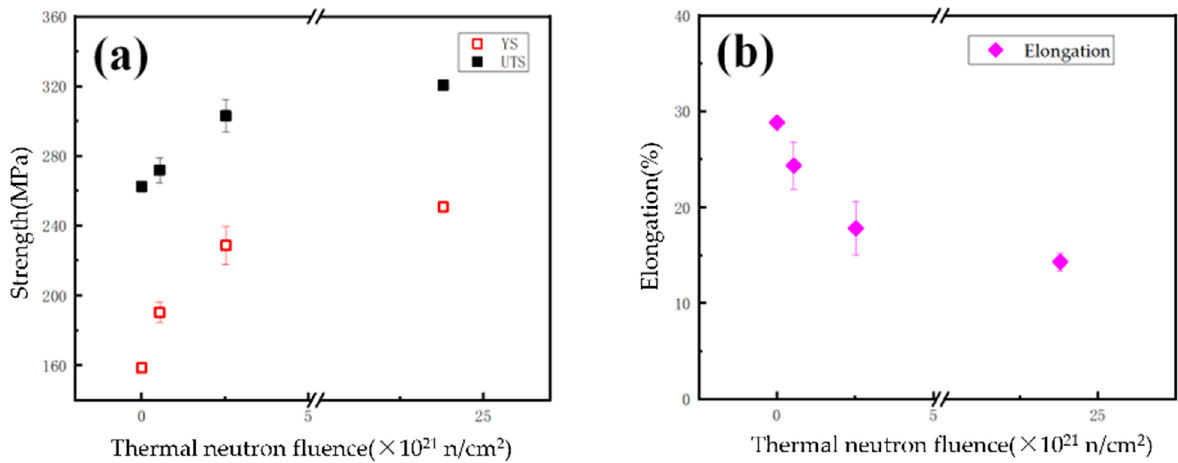
Figure 5. The relationship between the tensile properties of LT21 and the thermal neutron fluence: ( a ) strength vs thermal neutron fluence; ( b ) elongation vs thermal neutron fluence.